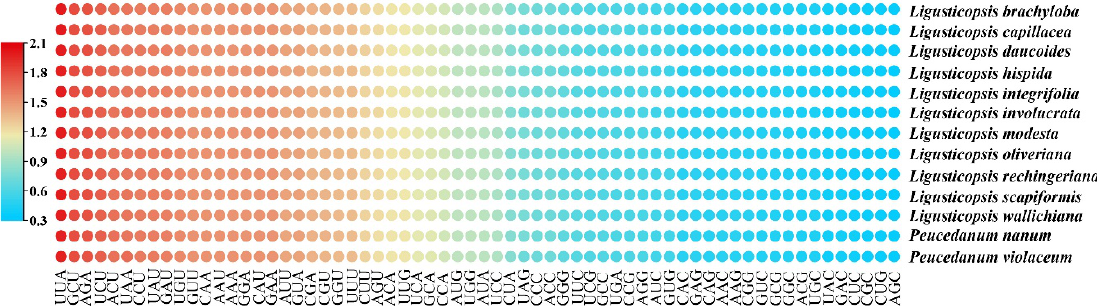
Figure 3. The RSCU values of 79 protein-coding regions for thirteen plastomes. Red represents higher RSCU values, while blue indicates lower RSCU values.